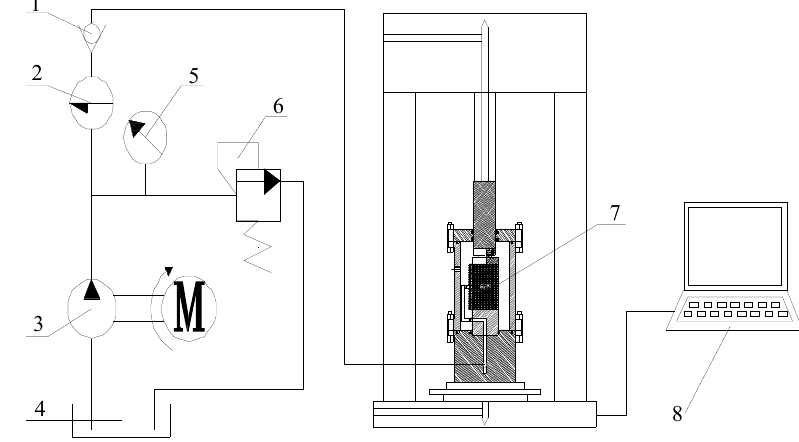
Figure 2. Osmosis system: (1) check valve; (2) flow meter; (3) hydraulic pump; (4) penetrant box; (5) pressure gauge; (6) relief valve; (7) osmosis device; and (8) computer.